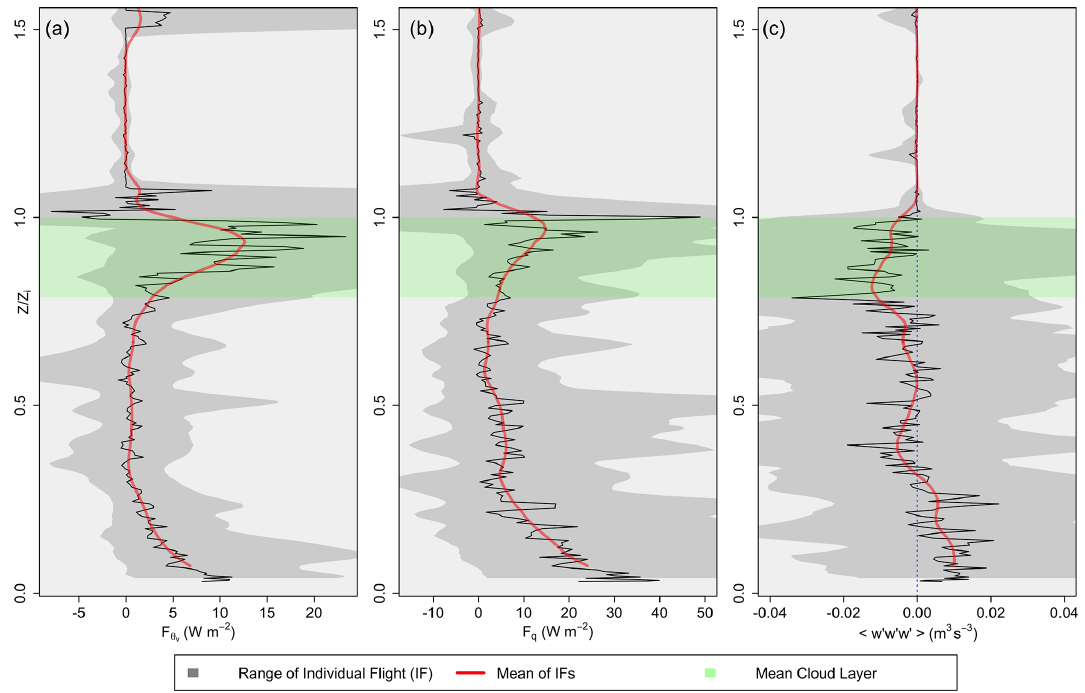
Figure 11. Vertical profiles (from data collected during flight profiles) of (a) F θ skewness (m 3 s − 3 ). The red line is the smoothed average of the raw data (black), while the gray envelope represents the range of values